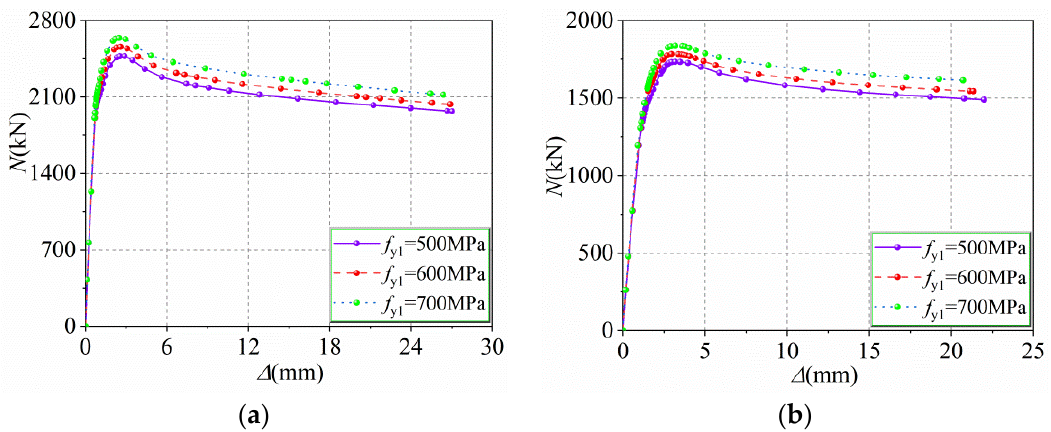
y1 : ( a ) e = 20 mm; ( b ) e = 50